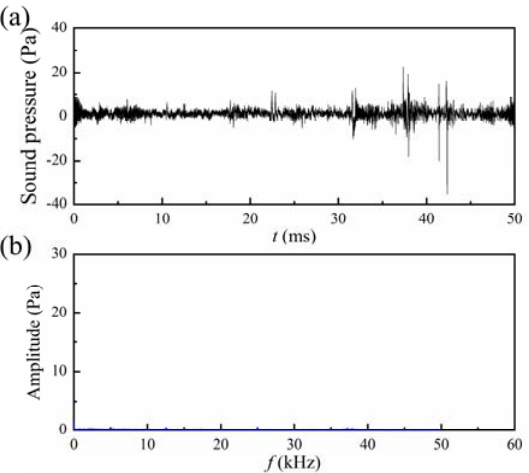
Figure 7. The sound pressure in conventional FCA welding arc in the air. ( a ) the time ‐ domain image; ( b ) the frequency ‐ domain image.